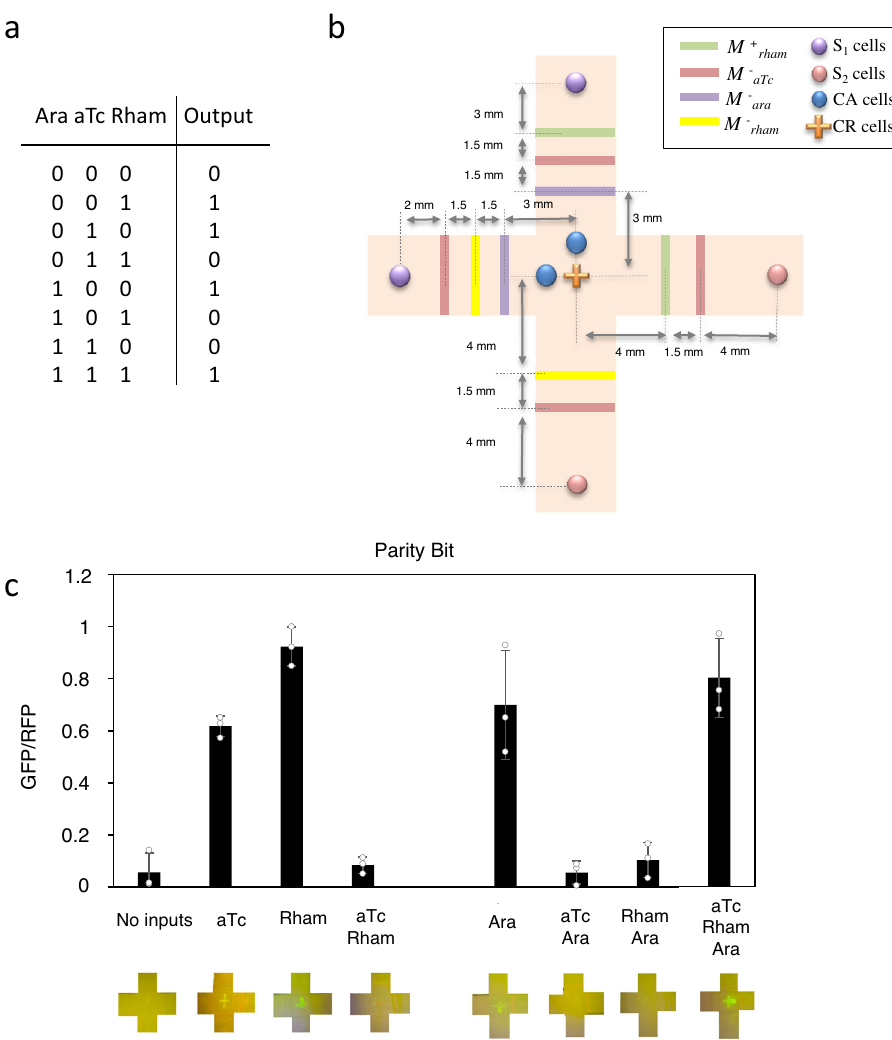
Fig. 5 Parity bit. a Truth table of the even parity bit circuit. b Spatial pattern of the cells encoding the truth table. This circuit involves four branches, with the fi nal output in the middle. The output cells CR were printed as a cross to visualize from which branch comes dominantly the AHL signal. M + aTc and M − aTc are, respectively, positive and negative modulatory cells responding to aTc. M + rham and M − rham are, respectively, positive and negative modulatory cells responding to rhamnose. S 1 cells produce AHL constitutively and S 2 cells produce AHL upon arabinose induction. c Multiplexer response upon input of the indicated combinations. In this circuit, due to the amount of modulatory elements per branch, auto-ampli fi er cells (CA) were incorporated close to reporter cells (CR). These cells amplify the signal on the presence of AHL. Input concentrations are ara = 10 − 3 M, aTc = 10 − 6 M and rham = 1.5%. Error bars are the standard deviation (SD) of three independent experiments. Data are presented as mean values± SD. The average fold change has been obtained from the mean of ON and OFF states from each input combination. Parity bit fold change: 10.47x Source data are provided as a Source Data fi printed circuits. For it, an example of an analogic circuit, i.e. a band-pass fi lter, was implemented using the same elements described in Fig. 1, except that cell type S 1 (constitutive pro- duction of AHL) was replaced by S 2 (arabinose-inducible pro- duction of AHL). This allows the introduction of an additional modulatory element as AHL production depends on the external input, in this case arabinose. At low arabinose concentrations, AHL levels are low due to the low production in S 2 cells. The combination of low AHL synthesis with the reduction of AHL due to its diffusion does not allow AHL-induced output pro- duction by CR cells. In contrast, at high arabinose concentrations, although the higher AHL secretion, it also induces the production of Aiia by the modulatory element (M − ara cells) located between S 2 and CR cells, which degrades the diffusing signal and therefore, blocks the AHL fl ow and the output is not produced. However, at intermediate arabinose concentrations, the level of AHL secreted